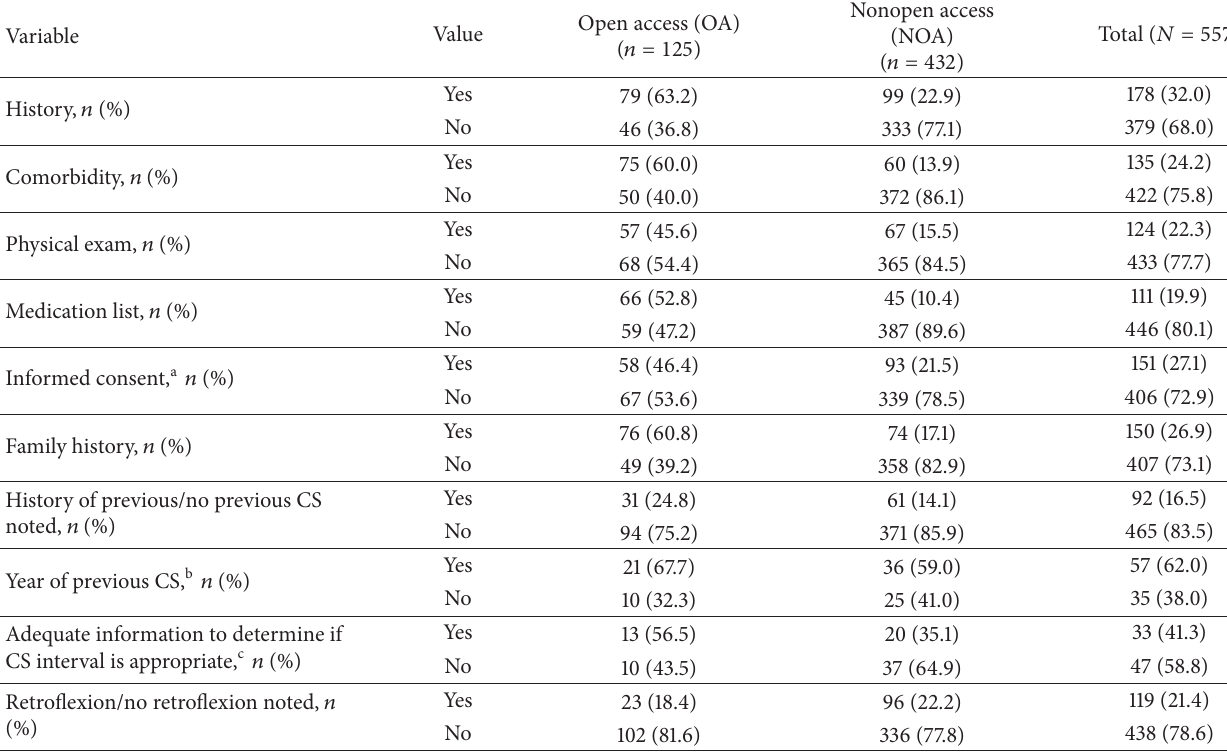
Table 4: Number and proportion of selected ∗ nonmandatory data elements documented among CS reports by open-access (OA) status.